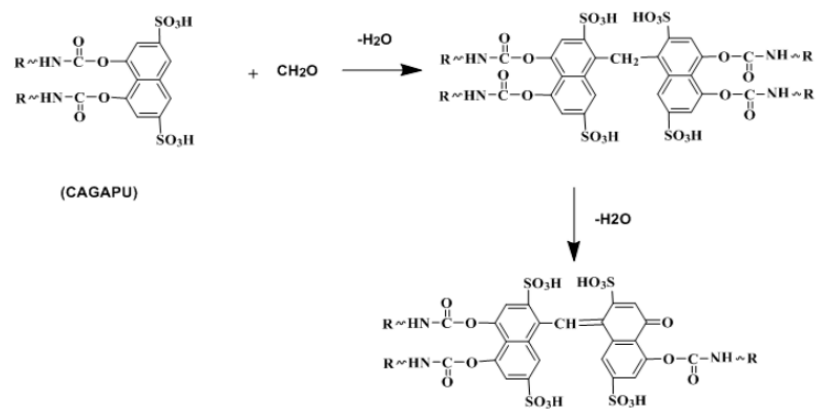
Figure 13. Reaction mechanism of CAGAPU with formaldehyde [88].